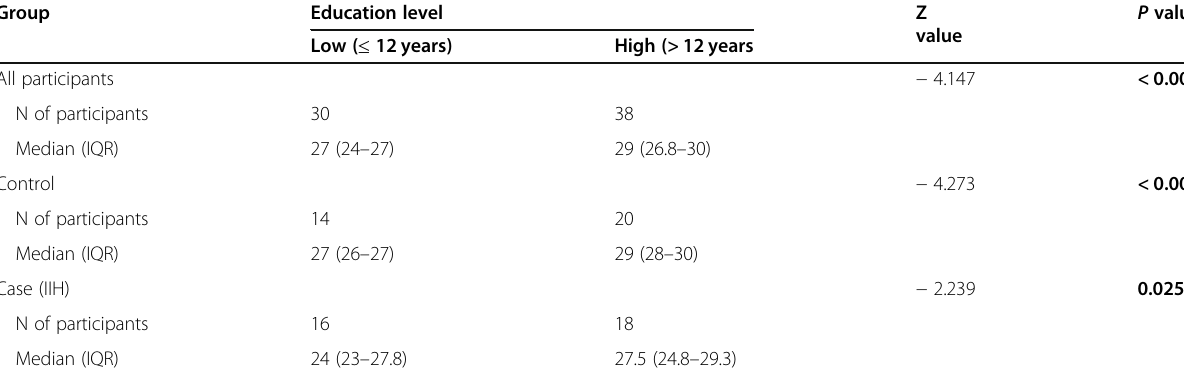
Table 6 MOCA score in case and control groups according to education level Group Education level Z